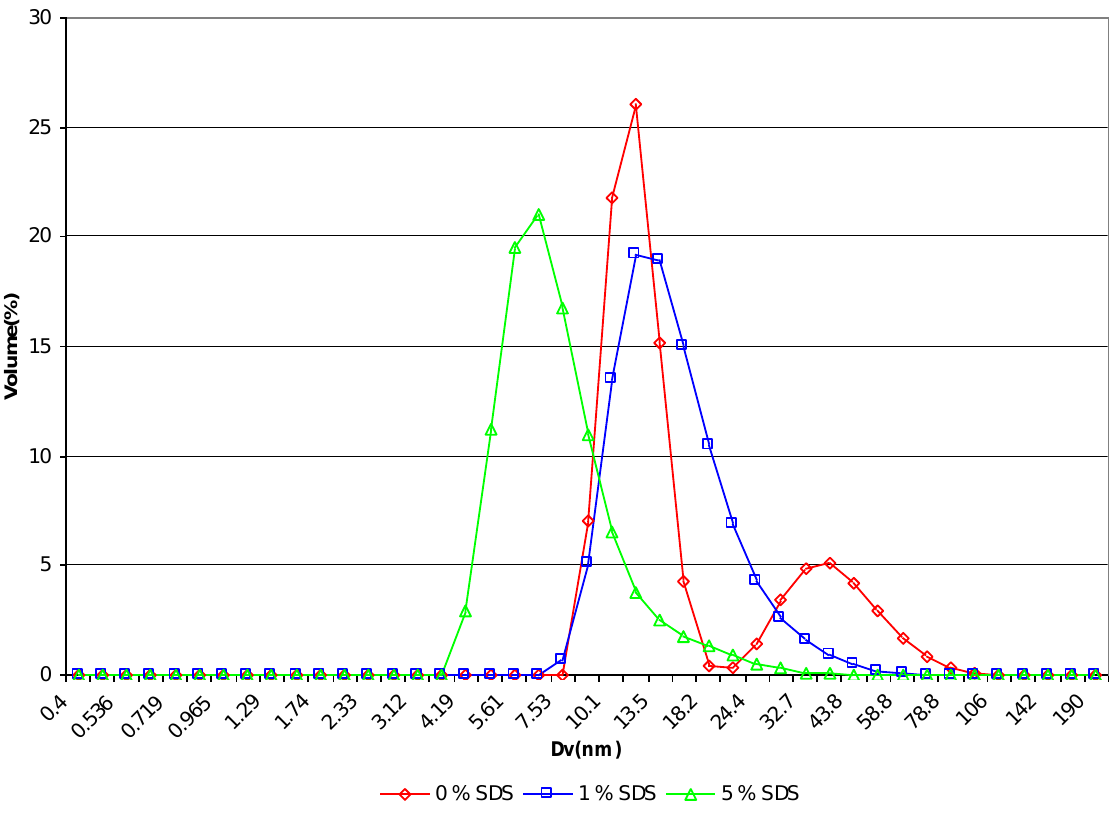
Figure 4. DLS-size distributions: Dv for fraction F solution at 20 °C) at different SDS concentrations indicated with respect to PVA.